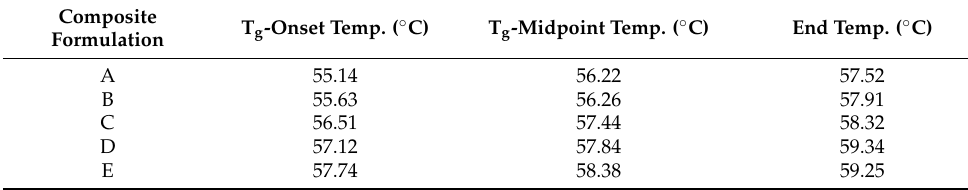
Table 4. T g -onset, midpoint, and end temperatures of the